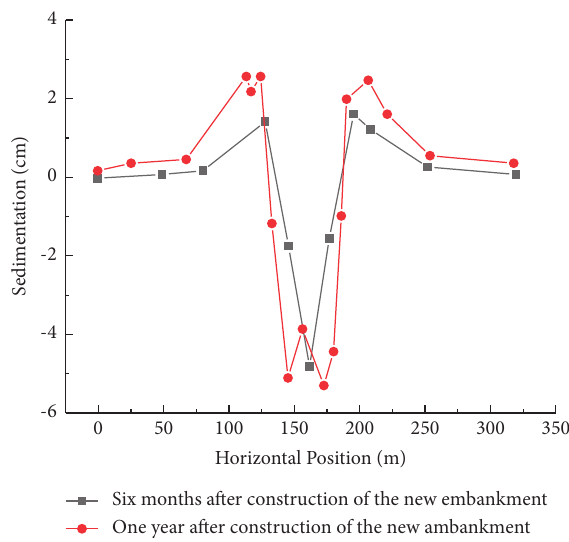
Figure 6: Sedimentation of foundation surface (condition